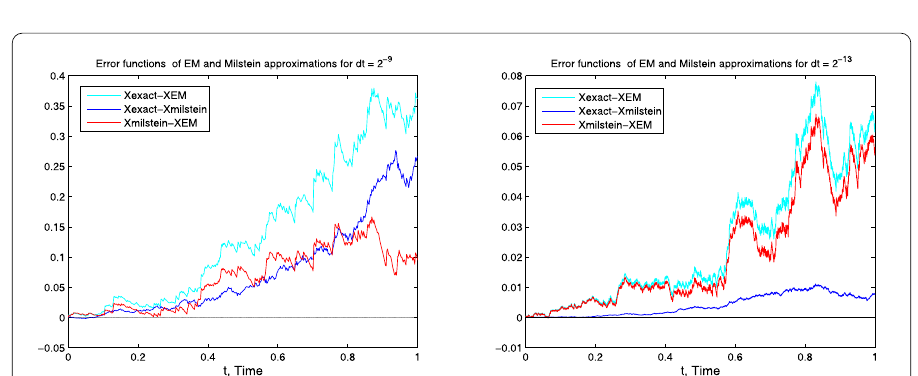
each stepsize. Xexact – XEM , Xexact – Xmilstein denote error function of EM and Mil- stein approximations in each stepsize, which is plotted as aqua and blue straight lines, respectively. Xmilstein – XEM means the difference between EM and Milstein